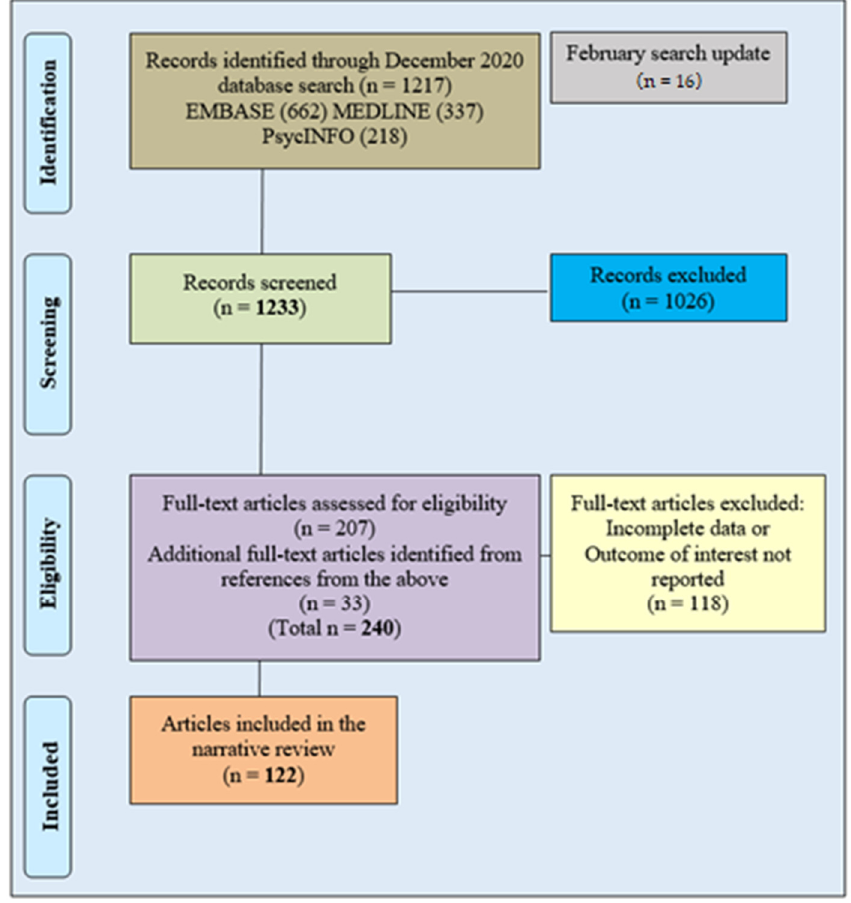
Figure 1. Article search and selection flowchart.